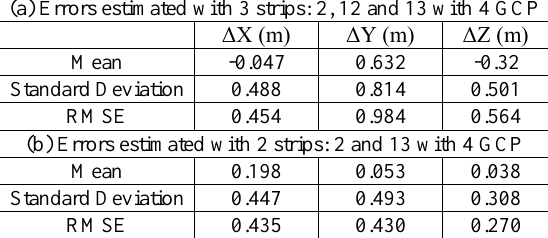
Table 3. Errors for 4 GCPs measured in point clouds: in (b) strip 12 was removed from the data.